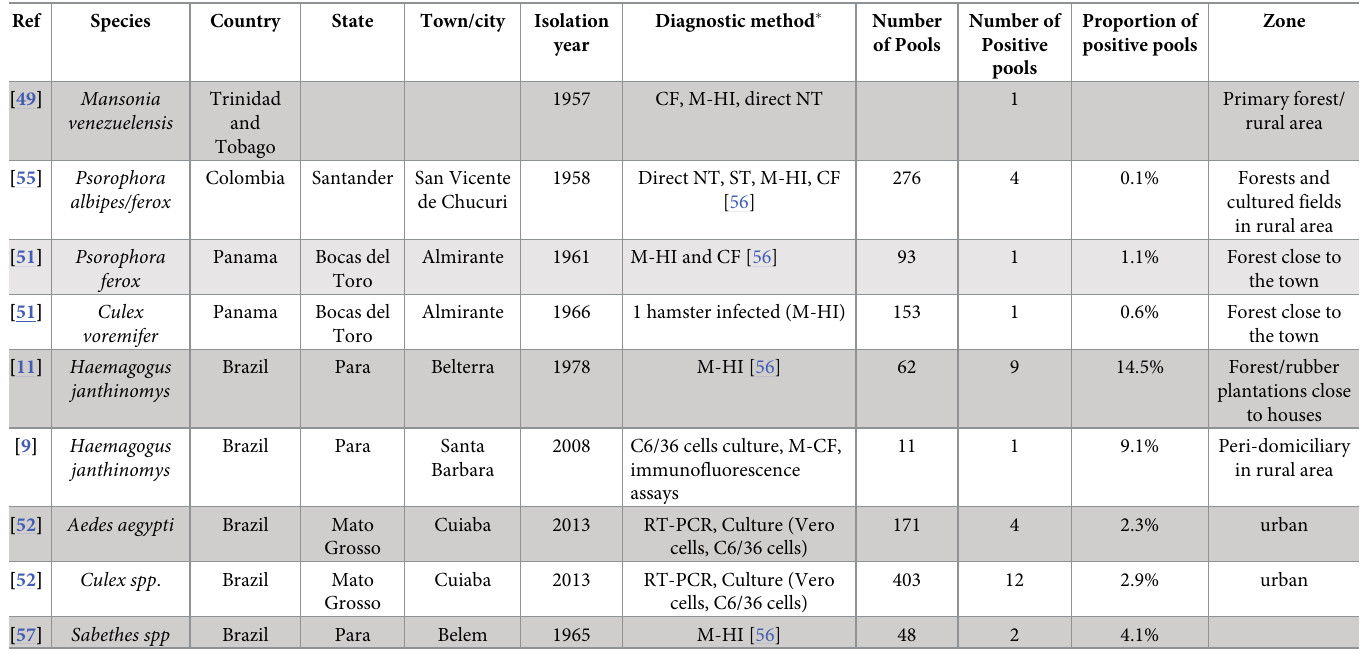
Table 2. Evidence of natural infection of MAYV in mosquitoes.